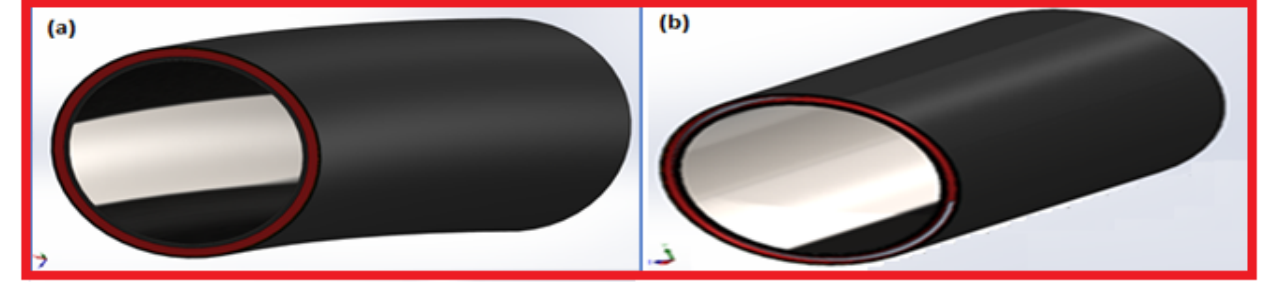
Figure 2. Marine hose model showing ( a ) reeled section representing a bending curvature section, and ( b ) unreeled section representing a straight section in Solidworks version 2020.